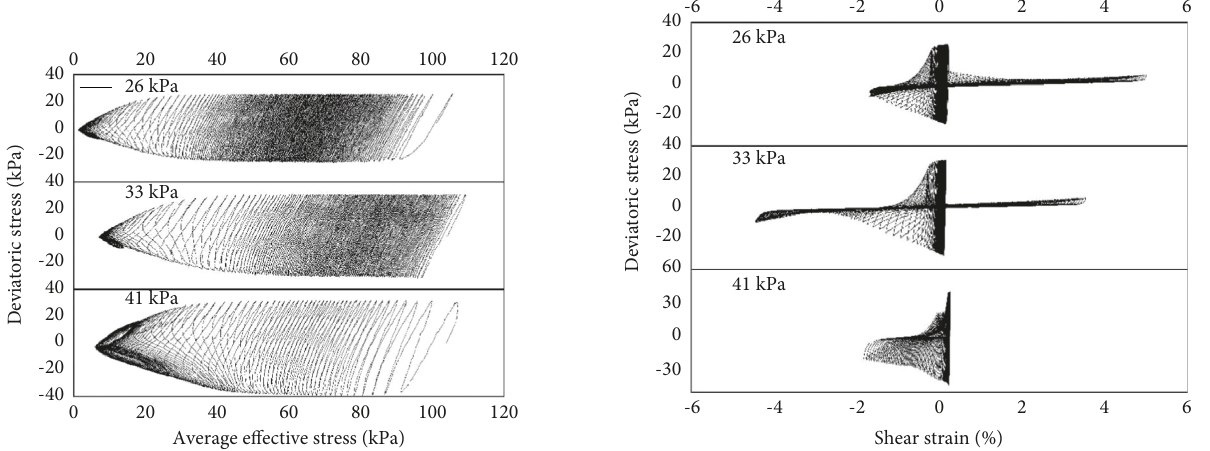
Figure 6: Effective stress path curve of the standard sand axis. Figure 8: Stress-strain curve of standard sand (dispersion).